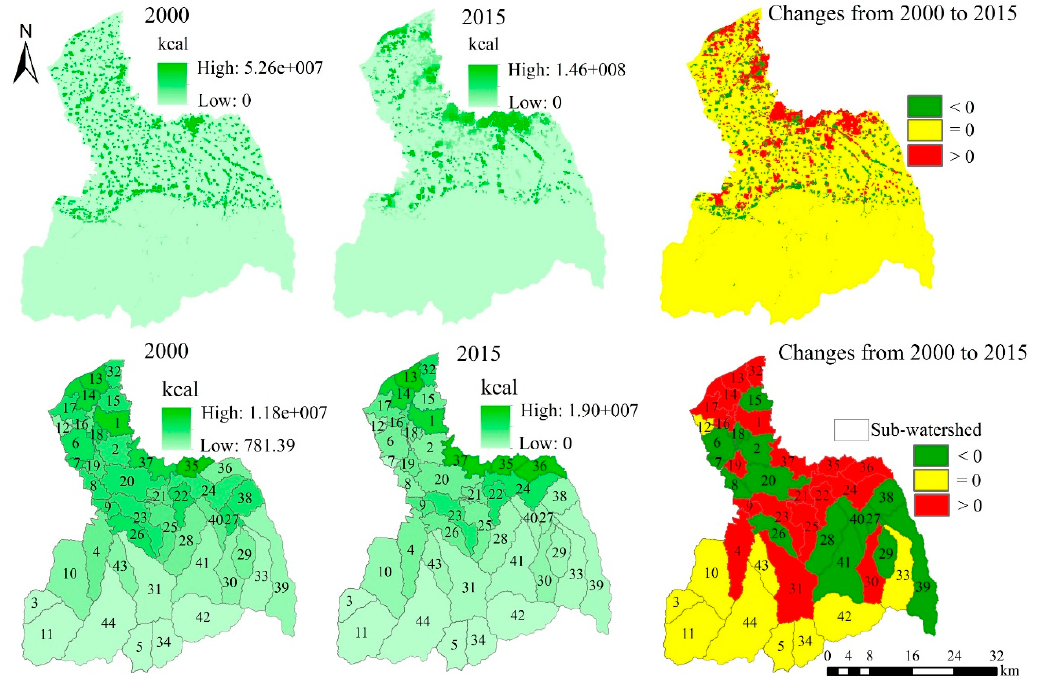
Figure 8. The spatial distribution and spatial–temporal changes of food demand. Int. J. Environ. Res. Public Health 2020 , 17 , x FOR PEER REVIEW